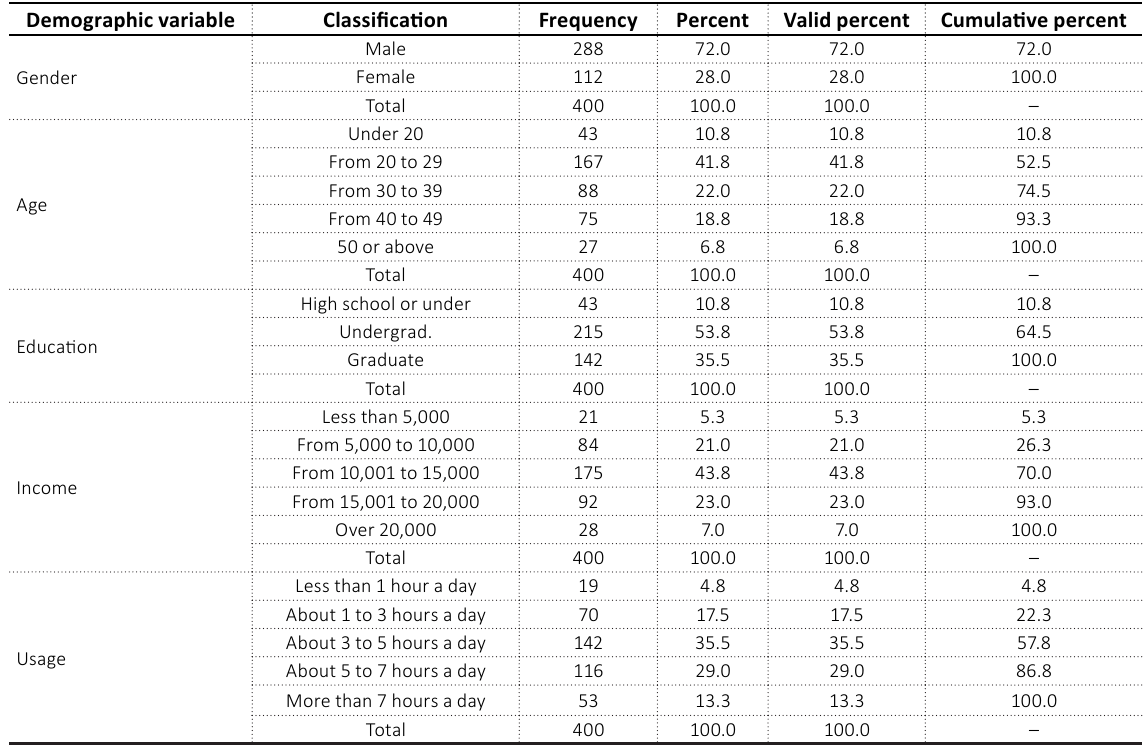
Table 2. Personal information of